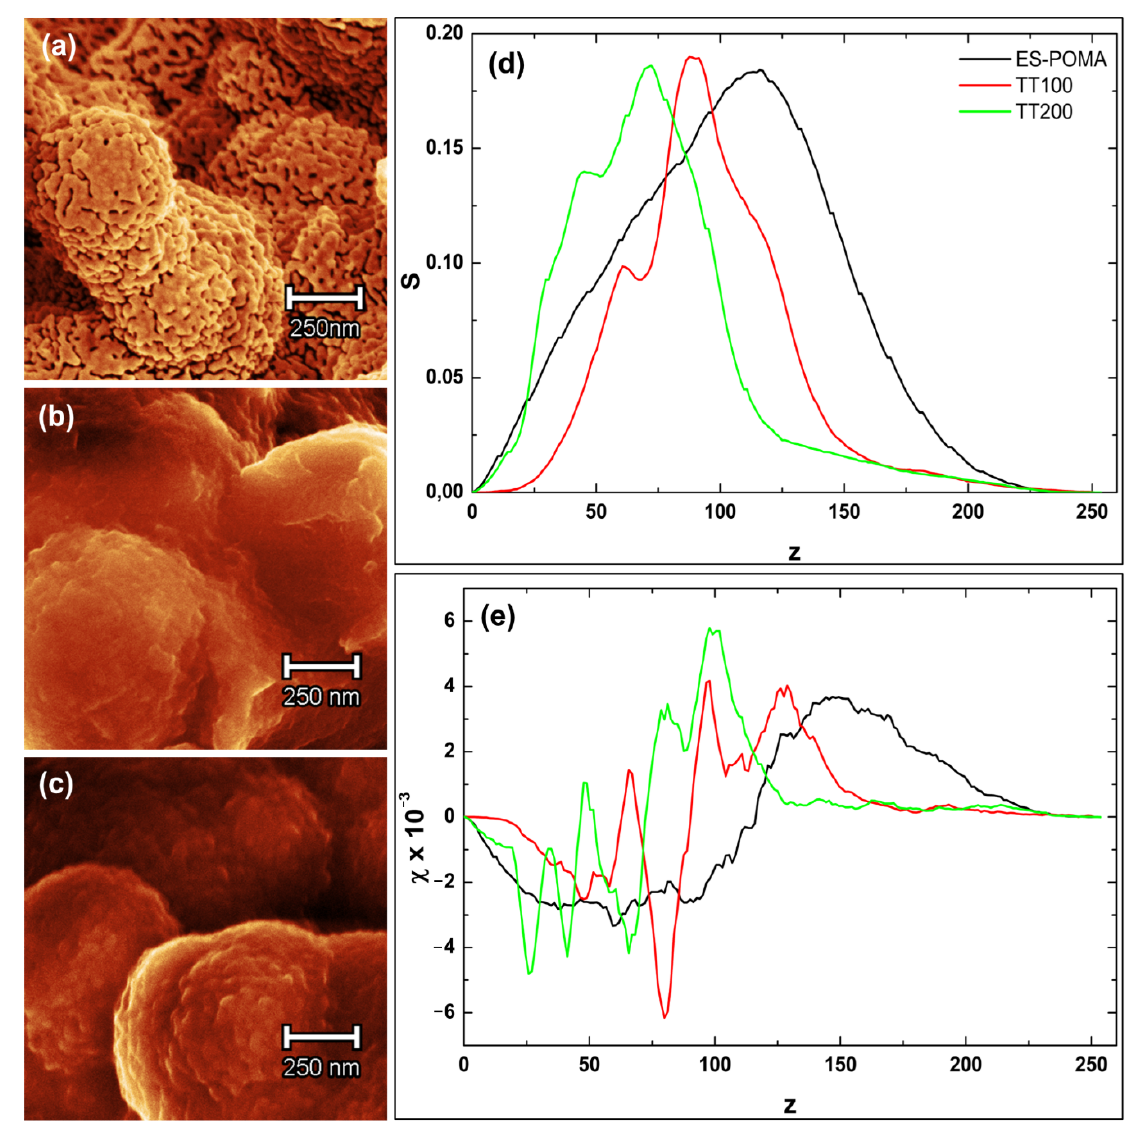
Figure 6. Two-dimensional zoom reconstruction of SEM images (100,000×) from ( a ) ES-POMA, ( b ) TT 100 , and ( c ) TT 200 . Representation of the ( d ) Minkowski surface and ( e ) Minkowski connectivity functions of images ( a – c ).